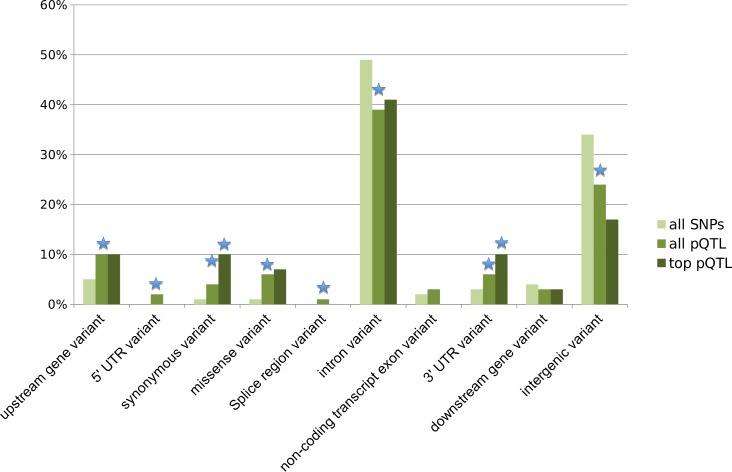
Consequences of pQTL SNPs.We examined the most significant SNP for each biomarker (top pQTL) and all 590 significant pQTL SNPs (all pQTLs), compared to all 664,913 SNPs (all SNPs) used for testing with the Ensemble Variant Effect Predictor (release 78). Upstream refers to within 5 kb and downstream refers to more than 5kb distant. All pQTL SNPs were enriched for missense, synonymous, upstream and 3′ UTR variants compared to all SNPs tested on the genotyping platform, while pQTL SNPs occurred less frequently in introns and intergenic regions (binomial test p-value < 0.05 starred in blue). Most of these variant classes showed additional enrichment or reduction for the top pQTL SNPs.